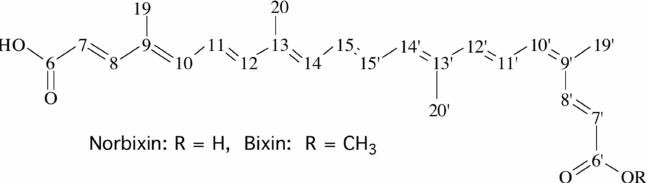
Fig 1. Structural formulae of bixin and norbixin. These two 6,6’-diapocarotenoidsare represented here as the 9’- cis isomers used in the present study. They may theoreticallyoccur as many isomers, as each double bond may be either cis or trans